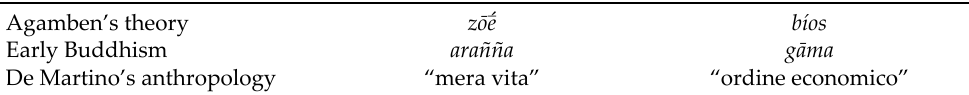
Table 2. Agamben’s and De Martino’s anthropological theory compared to the Buddhist vil‑ lage/forest